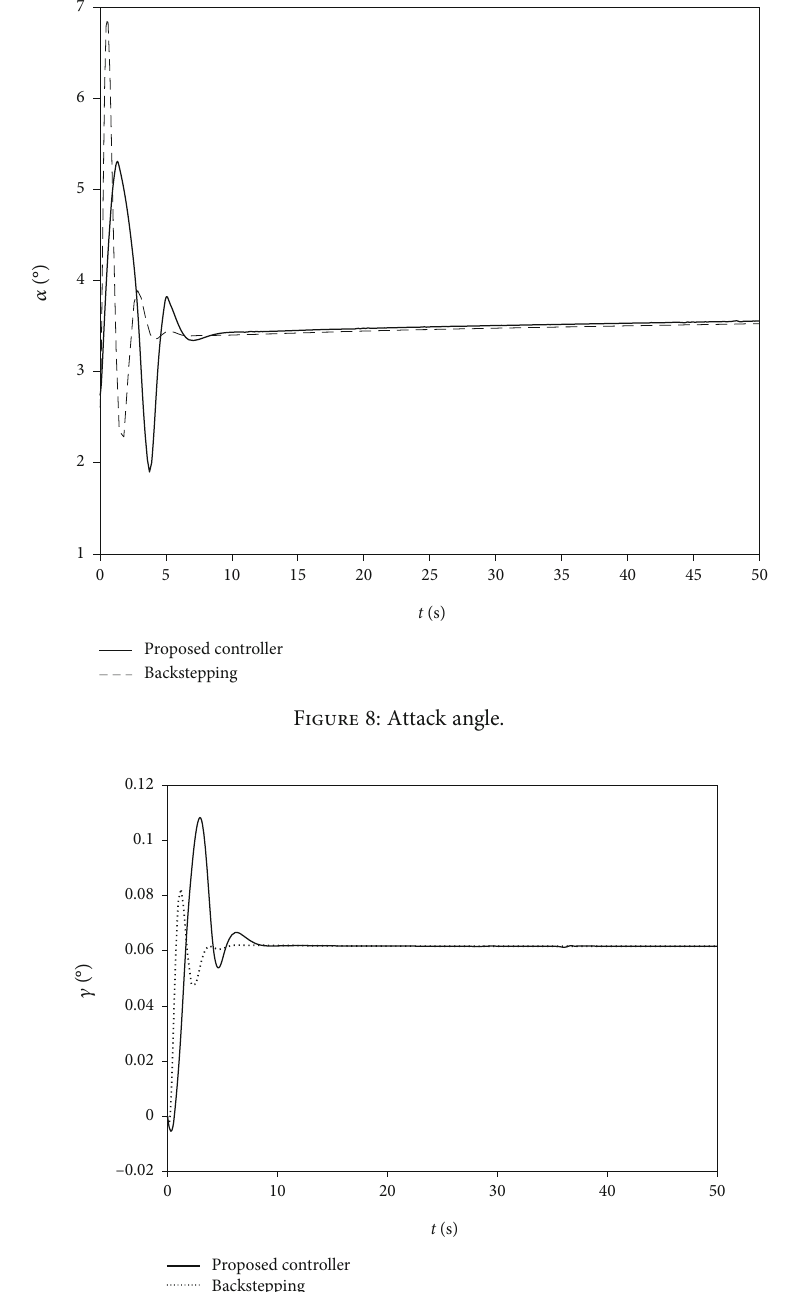
Figure 8: Attack angle.